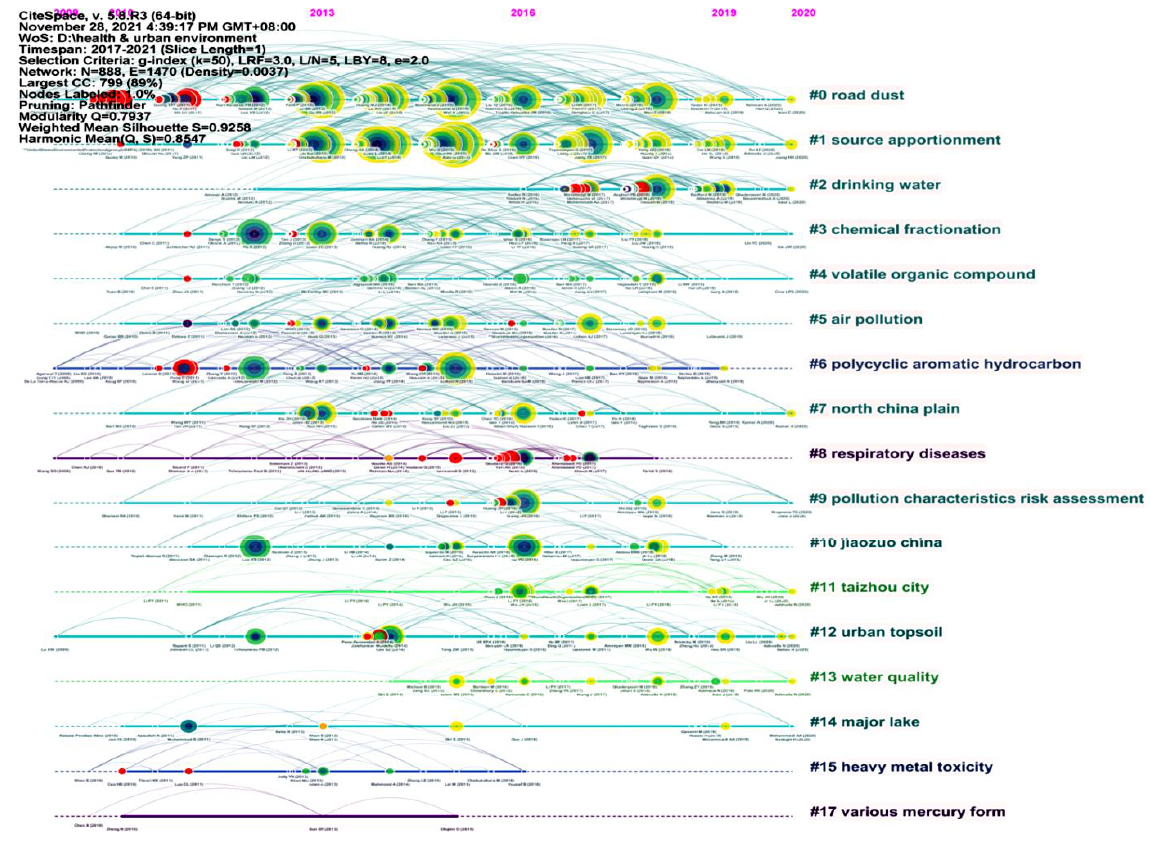
Figure 9. A timeline visualization of clusters on urban HIA research in